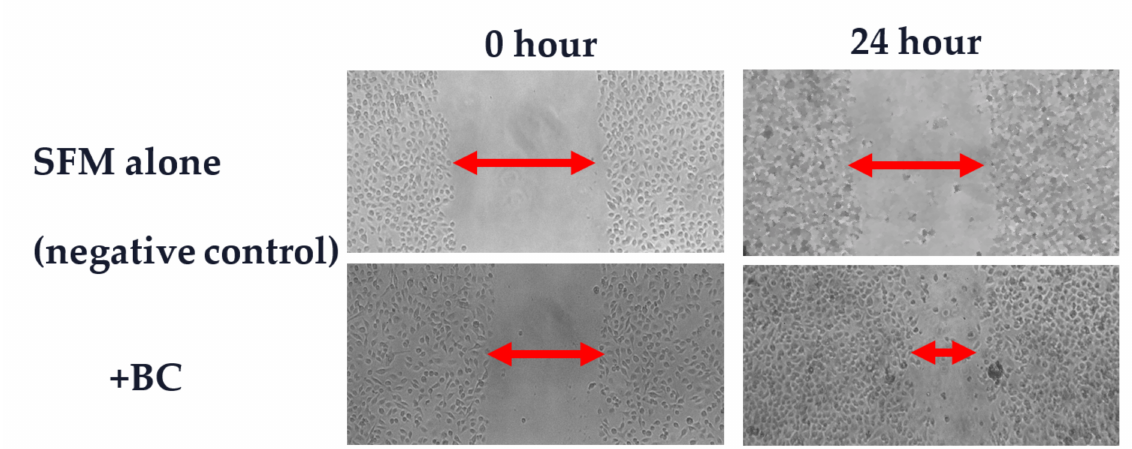
Figure 4. Effect of BC on cell migration. Human colonic Caco-2 cells were grown as a continuous monolayer and a standardised wound produced at time 0. The amount of closure of wound was assessed 24 h later. The presence of BC significantly increased the rate of closure compared to cells grown in serum free medium (SFM, negative control)